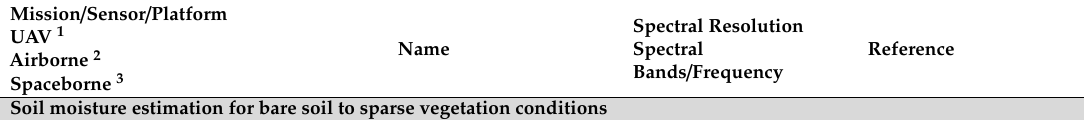
Figure 9. ( a ) Soil moisture estimation by the cosmic-ray neutron sensor (CRNS) rover in the Schäfertal agricultural field (from Schrön et al. [334]). ( b ) Measurement campaign in the Elbe-Mulde region around the City of Dessau (Germany) using detectors for cosmic-ray neutron albedo mounted on a gyrocopter. The aircraft operated at heights around 200 m above ground and circulated multiple times at certain points of interest (the floodplain, an agricultural field, the lake). Apparent measurement locations show collected neutron data over the course of 1 min. The footprint area in which 86% of measured neutrons were soil contact is indicated as a dashed rope (modified after Schrön [335]). Table 5. RS-aided derived traits of soil